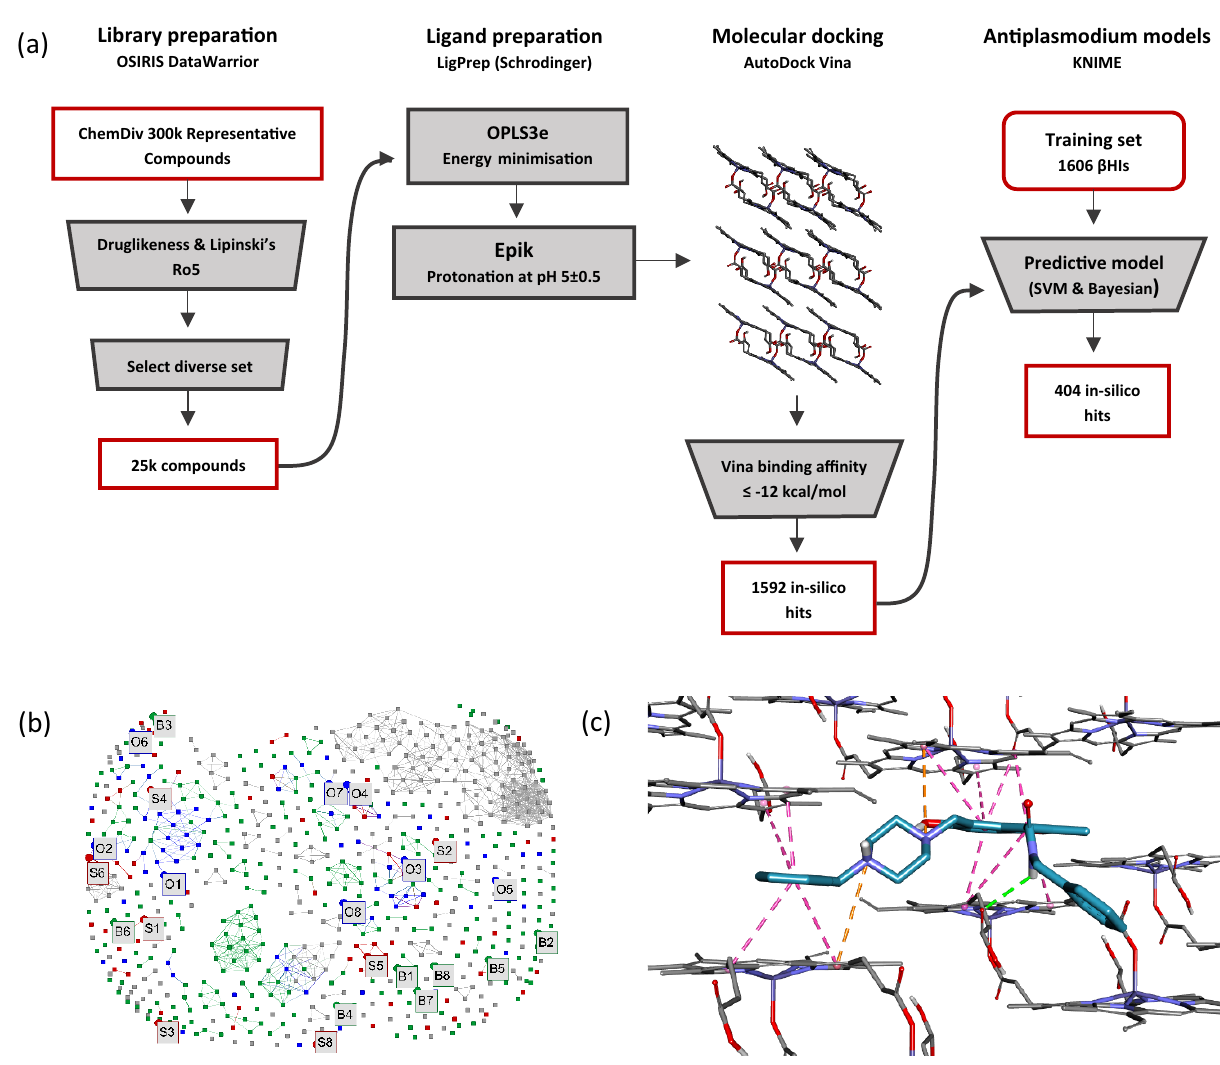
Figure 1. Virtual screening of the ChemDiv 300k Representative Compounds library and prioritisation of in-silico hits for purchasing and experimental testing against βH and whole-cell cultures of Pf . ( a ) Summarised computational workflow for predicting βH inhibition and antiplasmodium activity. ( b ) Similarity map of the 374 active compounds from the training set (black) and the 404 LBVS hits, which are categorised as SVM ( S , in red), Bayesian ( B , in green), and overlap ( O , in blue) based on which model(s) predicted them active, overlayed in chemical space. The map assisted in prioritising a set of 24 structurally unrelated compounds which excluded those scaffolds that have been previously investigated as βH inhibitors, i.e., those that appear frequently in the training set actives. ( c ) Purchased compound S4 docked at (001) face of βH. S4 forms multiple π-π stacking interactions (pink dashed line) with the parallel porphyrin rings and an (amine)NH···O(carboxyl) hydrogen bond (green dashed